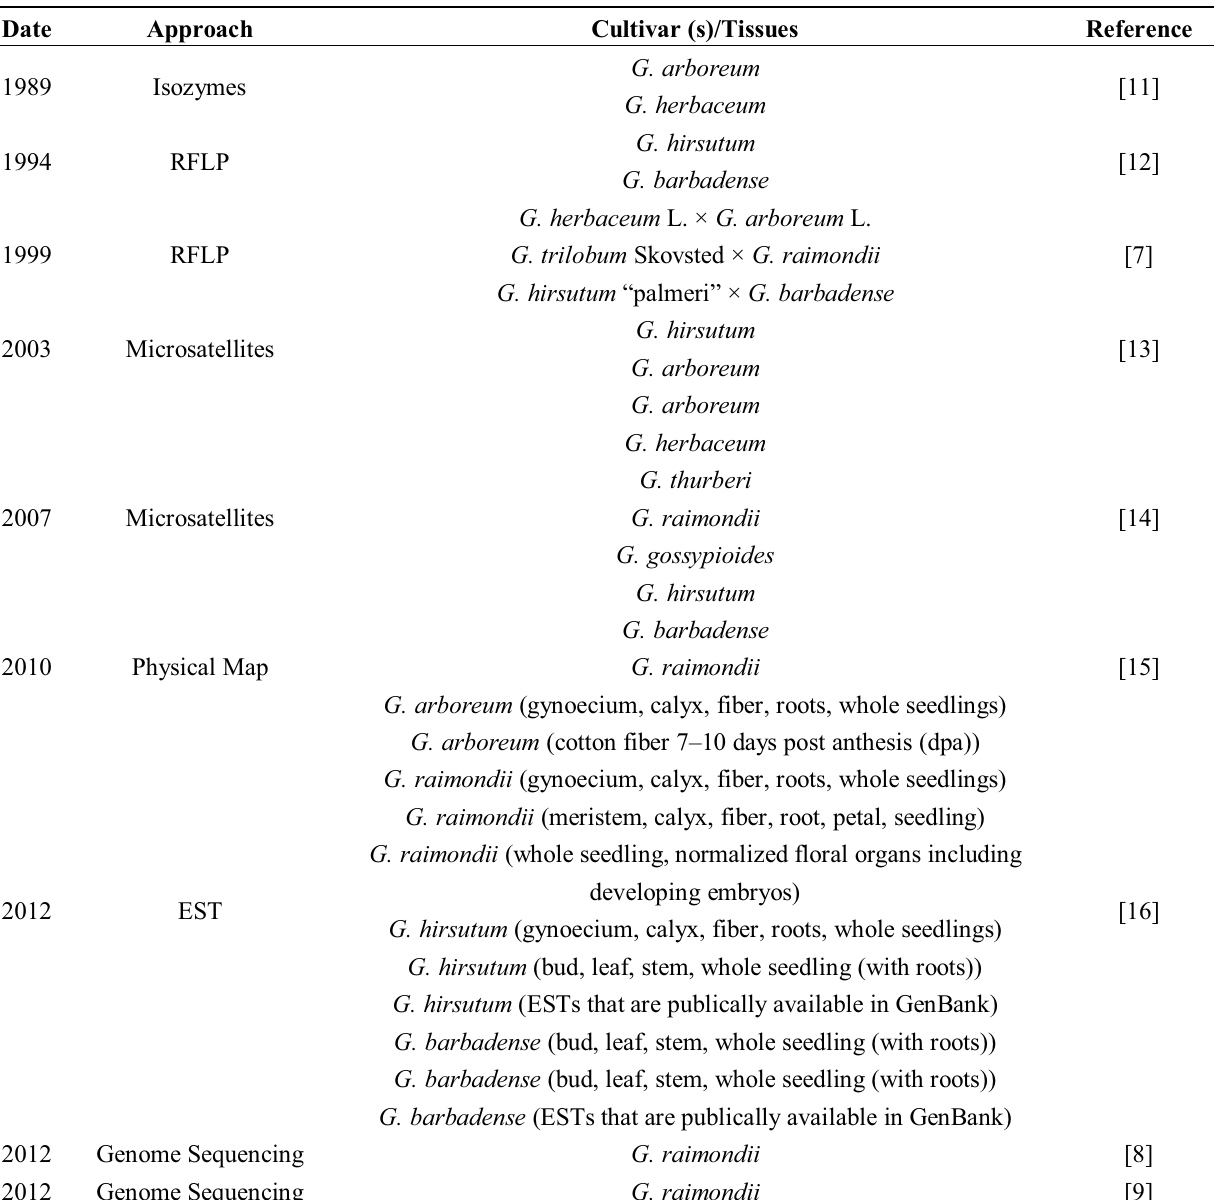
Table 1. Partial timeline for genetic studies of Gossypium . RFLP, restriction fragment length polymorphism. EST, expressed sequence